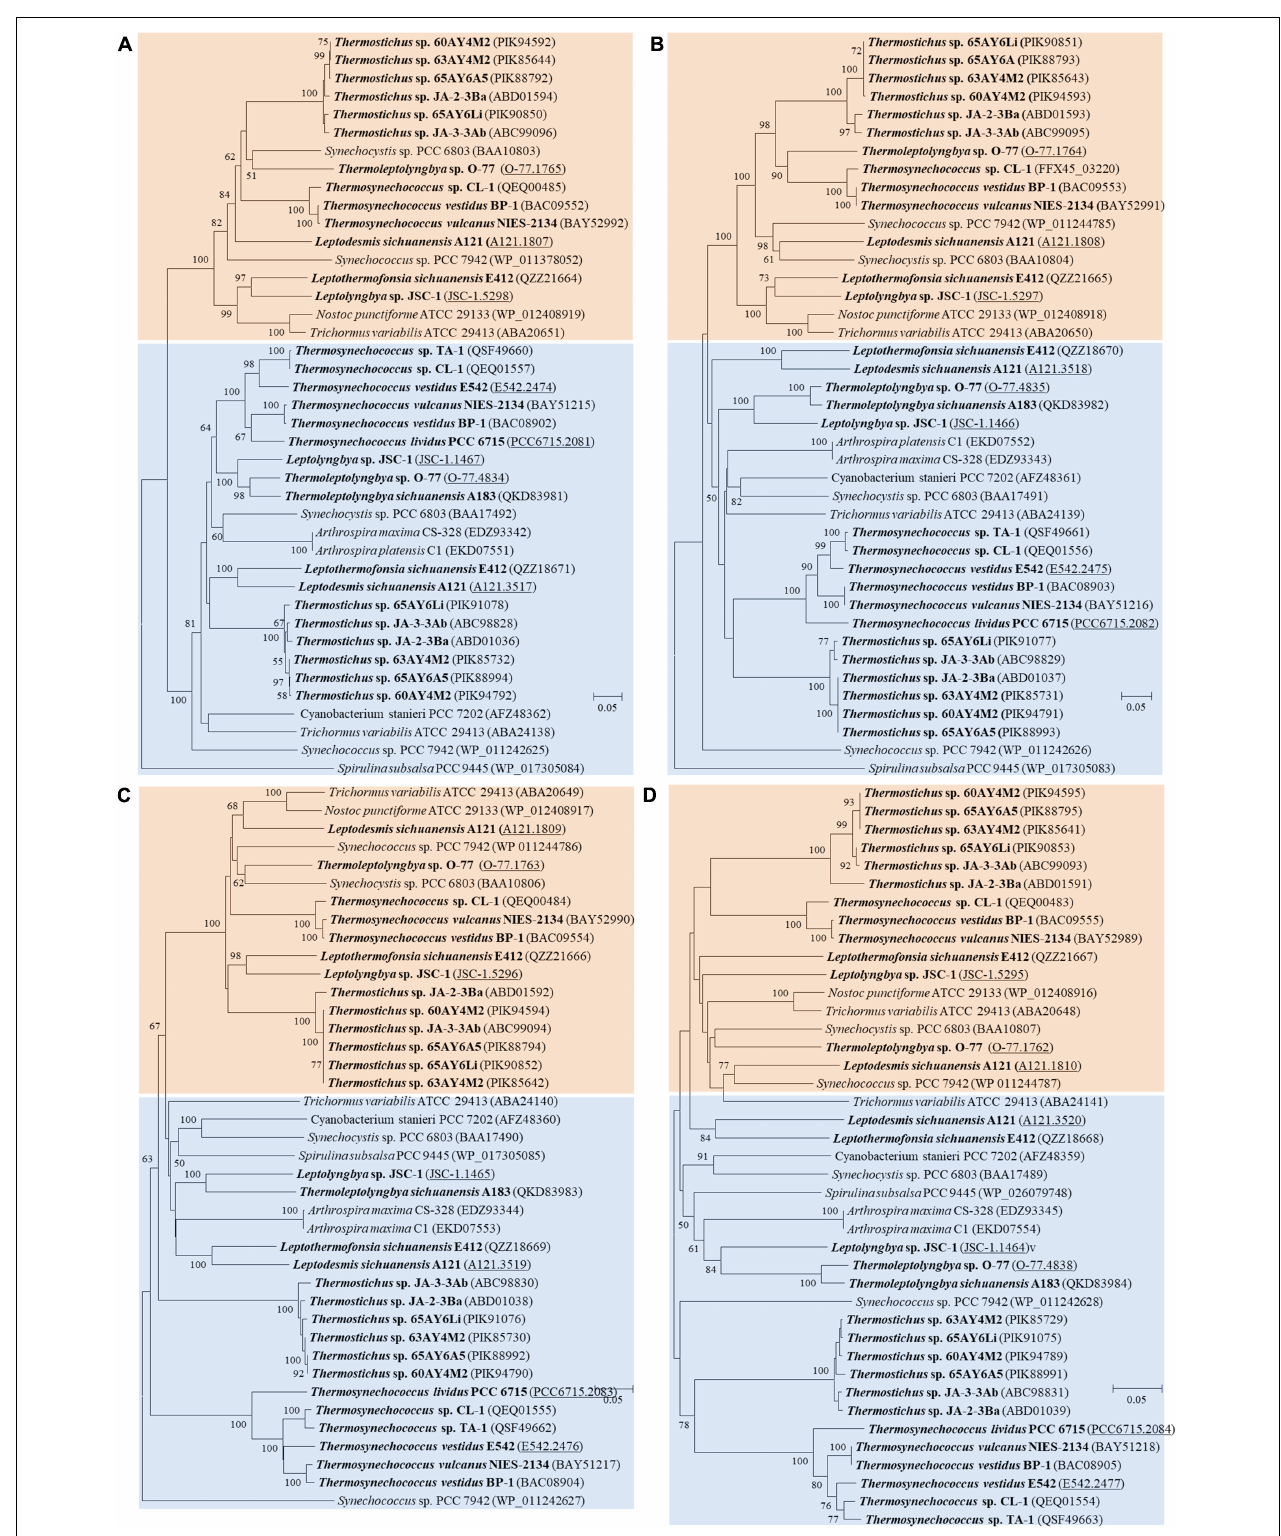
FIGURE 4 | Phylogenetic inference of protein sequences of cmp and nrt genes. (A) cmpA and nrtA ; (B) cmpB and nrtB ; (C) cmpC and nrtC ; (D) cmpD and nrtD . The thermophilic cyanobacteria investigated in this study are indicated in bold. The accession numbers underscored refers to the gene IDs in Supplementary Table 1 . Only bootstrap values > 50% are indicated at nodes.